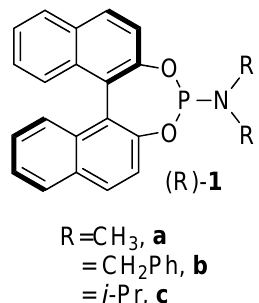
Figure 1. Phosphoramidite